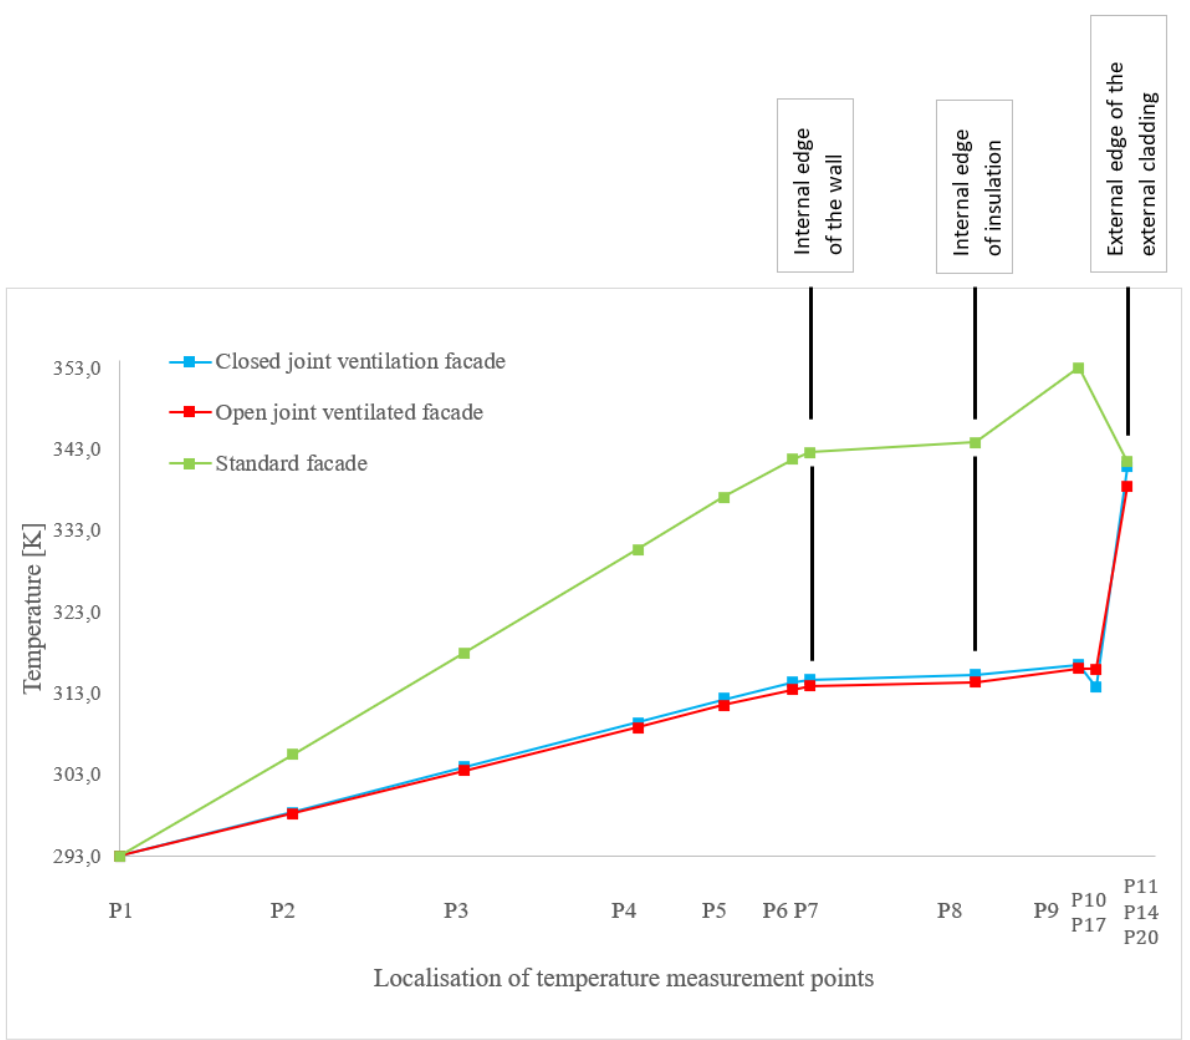
Chart 1: Temperature overview for the control points of the individual types of